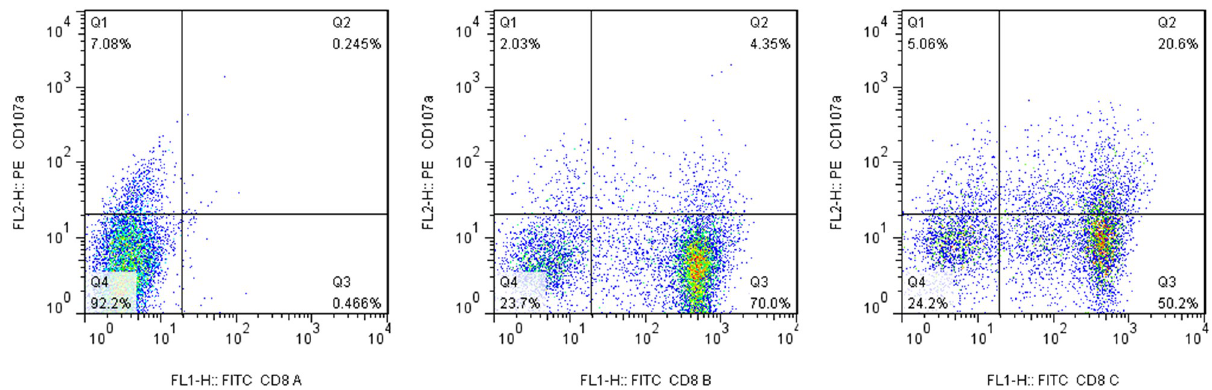
Fig 2. CMV antigen induced PBMC degranulation. Left: control group with no stimulationand fluorescence-labeledantibody addition; Middle: CD28antibody stimulationalone; Right: CD28antibody and CMV-pp65antigencostimulation.